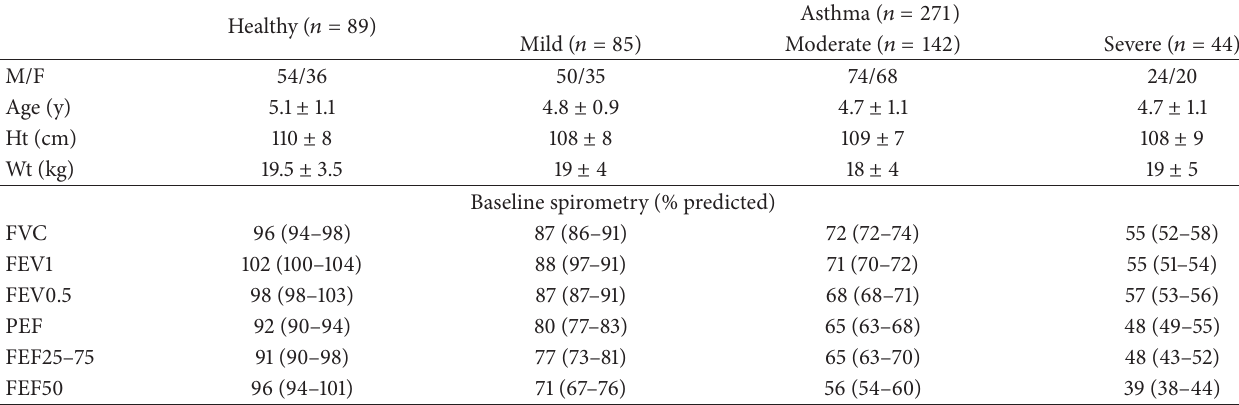
Table 1: Anthropometric and baseline lung function (% GLI).